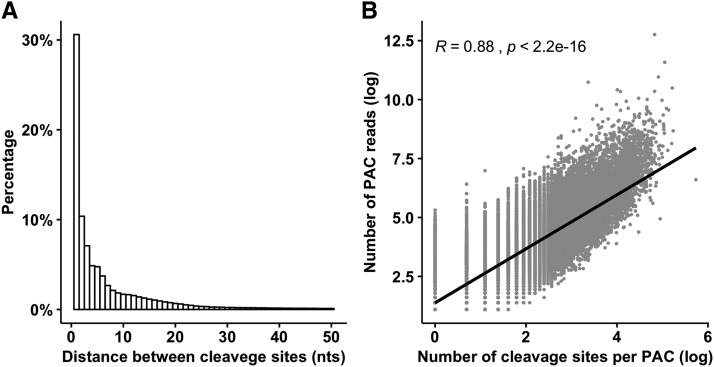
Micro-heterogeneity of cleavage sites in the maize genome. (A) Distribution of the distances between the adjacent cleavage sites. (B) Pearson correlation between natural logs of the number of cleavage sites and the number of supporting reads per PAC (R = 0.88, p-value = 2.2 × 10−16).